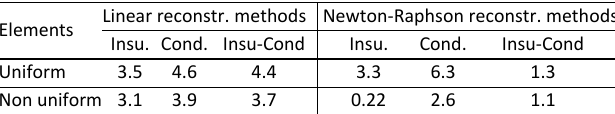
Table I: Error analysis on spatial resolution of linear and Newton-Raphson reconstruction methods using insulator, conductor or a combination Linear reconstr. methods Newton-Raphson reconstr. methods Elements Insu. Cond. Insu-Cond Insu. Cond. Insu-Cond